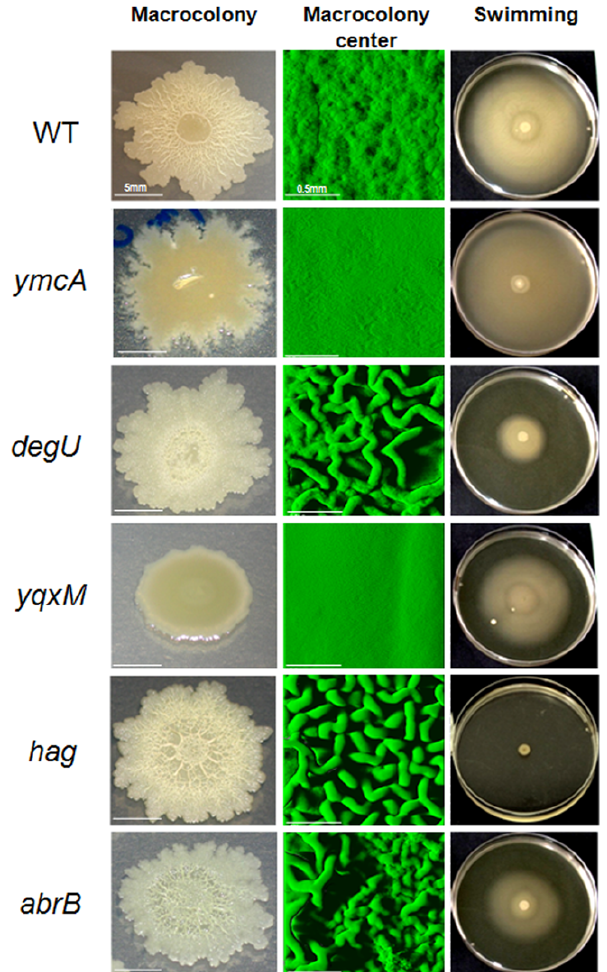
Figure 6. Effects of ymcA , ylbF , degU , yqxM , hag and abrB mutations on macrocolony and swimming phenotypes. Macro- colonies grown on TSA medium (1.5% agar) for 72h at 30 u C. The left- hand column depicts macrocolony morphologies. The scale bar is 5mm. The middle column depicts aerial views of the centers of macrocolonies from confocal image series using IMARIS software. The scale bar is 0.5mm. The right-hand column shows the swimming plate (9 cm diameter, TSB + 0.25% agar) after 24h of incubation at 30 u